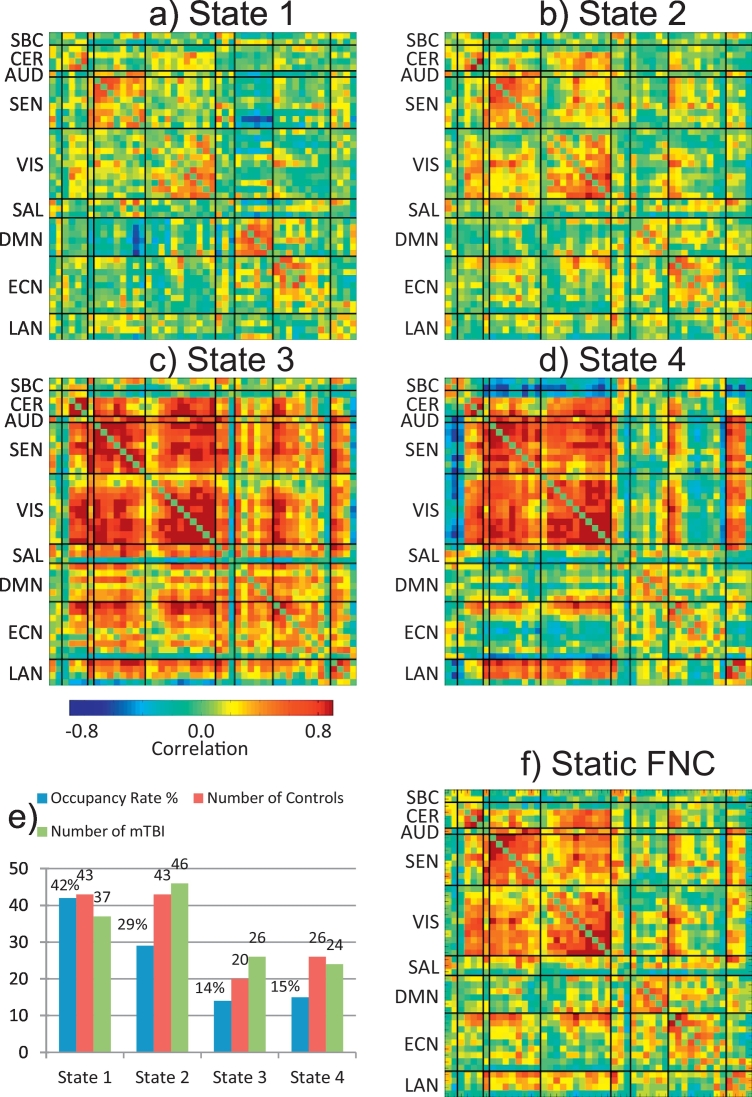
Centroids obtained for the four dFNC states (a–e). The figure includes the mean static FNC matrix (f), the occupancy rates and the number of subjects in each state (e). State 1 had the largest occupancy rate and State 3 the smallest. The number of mTBI and controls on each state are similar.